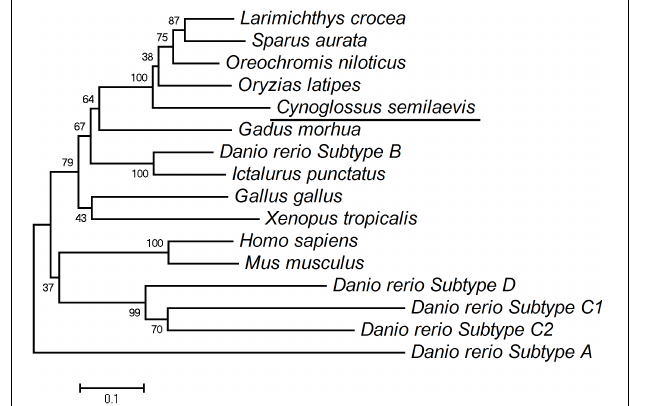
FIGURE 2 | Phylogenetic tree of Chinese tongue sole Ch25h. The amino acid sequences used in the phylogenetic tree included those from other teleost and other animals: human ( Homo sapiens ) (NP_067065.1), mouse ( Mus musculus ) (NP_034020.1), chicken ( Gallus gallus ) (NP_001264283.1), frog ( Xenopus tropicalis ) (XP_002935478.1), zebrafish ( Danio rerio ) (subtype A, ASU11038.1; subtype B, ASU11039.1; subtype C1, ASU11040.1; subtype C2, ASU11041.1; subtype D, ASU11042.1), channel catfish ( Ictalurus punctatus ) (NP_001188084.1), Nile tilapia ( Oreochromis niloticus ) (XP_003449518.2), medaka ( Oryzias latipes ) (XP_004084712.1), large yellow croaker ( Larimichthys crocea ) (XP_010750904.1), Atlantic cod ( Gadus morhua ) (XP_030195643.1), and gilthead seabream ( Sparus aurata ) (XP_030255276.1). The horizontal branch length is proportional to amino acid substitution rate per site. The numbers represent the frequencies with which the tree topology presented here was replicated after 1000 bootstrap iterations.